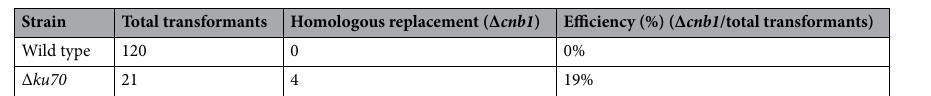
Table 1. Efficiency of homologous replacement on cnb1 gene